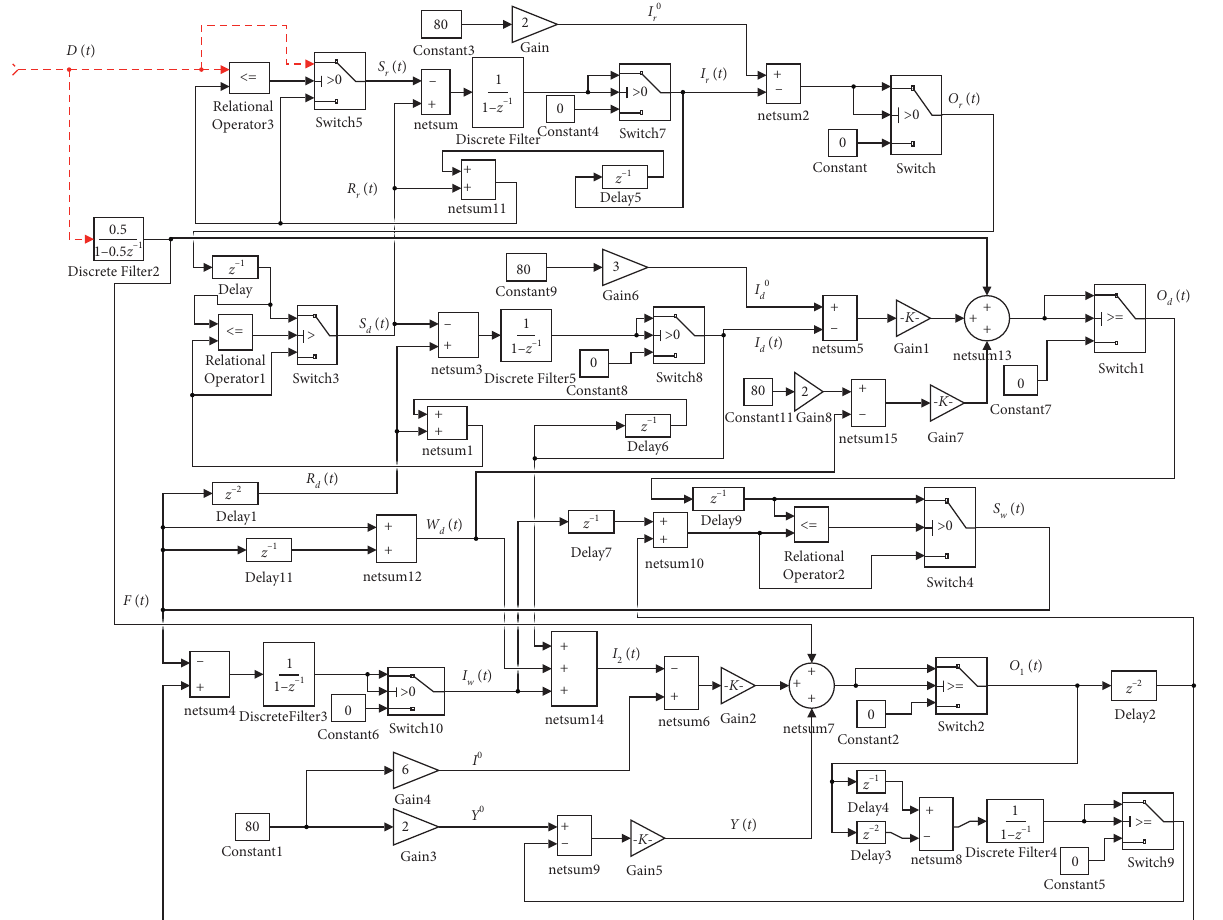
Figure 7: The block diagrams of the system under the local decision